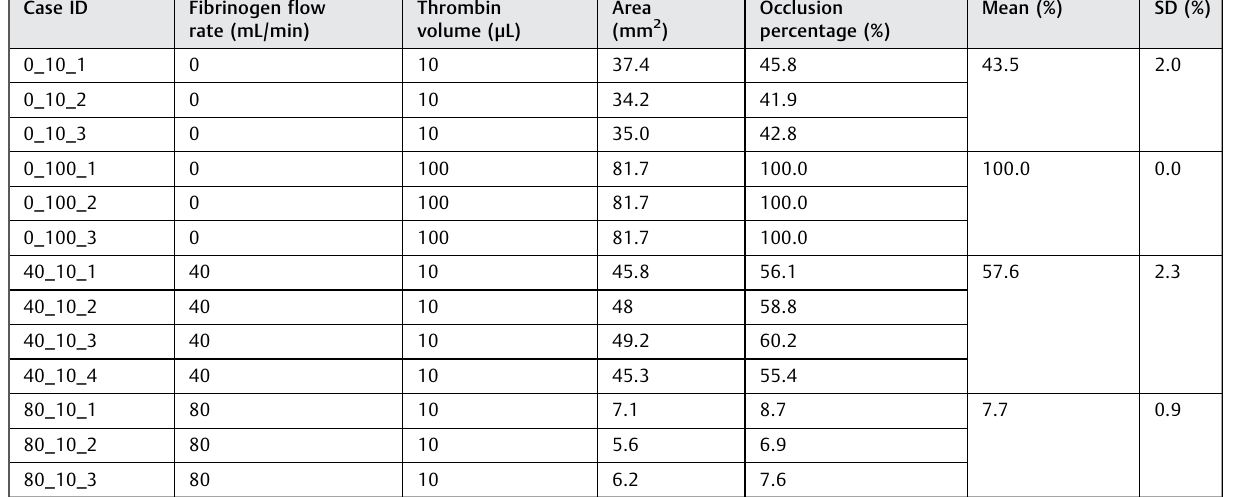
Table 1 Occlusion percentage for experimental runs using different fi brinogen fl ow rates and thrombin concentrations Case ID Fibrinogen flow rate